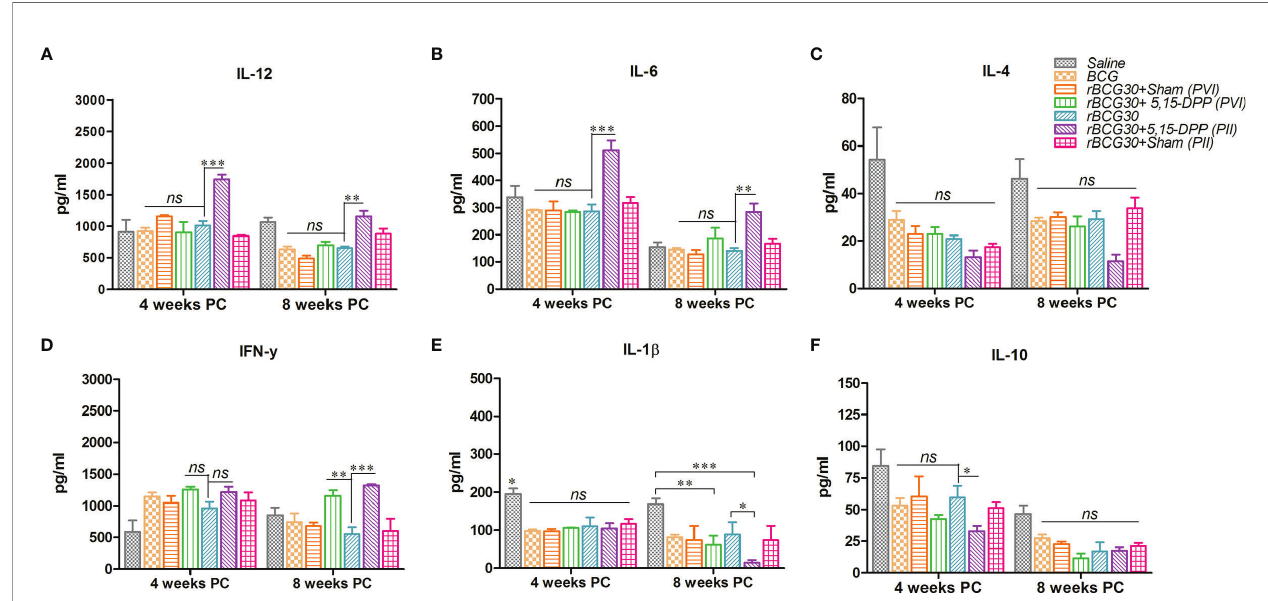
FIGURE 5 | Splenocytes production of signature pro-and anti-in fl ammatory cytokines at 4 and 8 weeks post-challenge. The level of signature Th1 cytokines IL-12, IFN- g (A, D) , innate cytokines IL-6, IL-1 b (B, E) , and anti-in fl ammatory cytokines IL-4, IL-10 (C, F) , were estimated using sandwich ELISA in splenocyte culture supernatants belonging to the various groups. Cells were uniformly stimulated with native Ag85B antigen from Mtb (5 µg/ml). Differential levels of cytokines between various groups are presented as bar diagrams. The data were analyzed employing Two-way ANOVA followed by Bonferroni ’ s multiple comparison test and are shown as the means ( ± SEM) from one of the two independent experiments with similar observations deduced from pooled cells of at least three mice per group and performed in technical triplicate, where p<0.05(*), p<0.01(**), and p<0.001(***) were considered signi fi